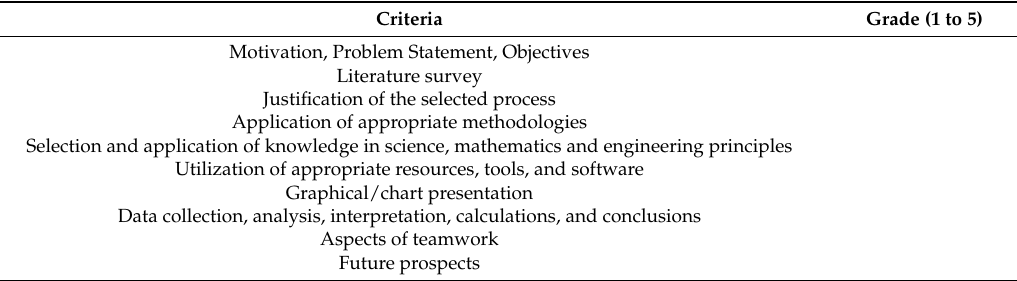
Table 8. Evaluation criteria and grades.